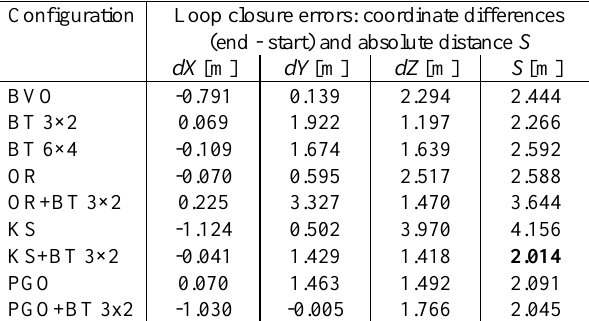
Table 3. Loop closure values in X , Y , and Z for our own dataset: the lowest value S is highlighted